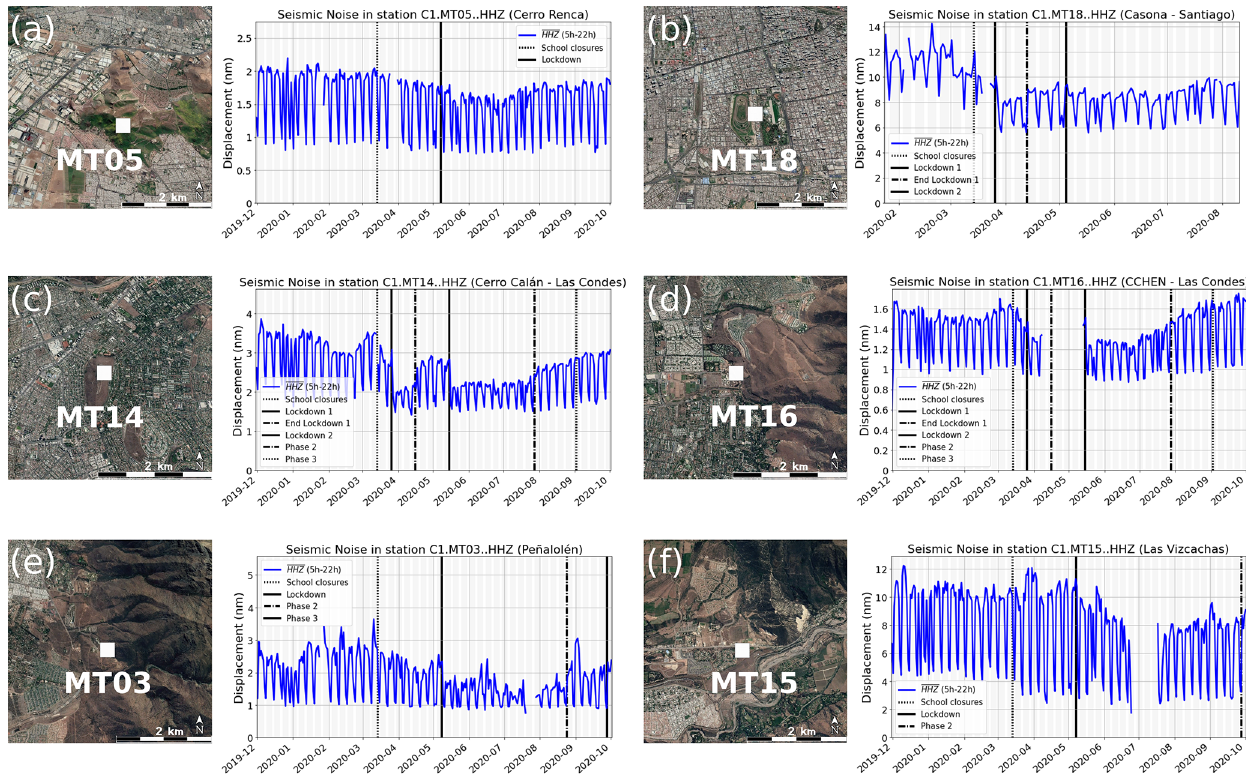
Figure 6. Changes in high-frequency seismic ambient noise amplitudes at stations (a) MT05, (b) MT18, (c) MT14, (d) MT16, (e) MT03, and (f) MT15. The vertical black lines indicate the time of public restrictions implemented in the metropolitan region. Each municipality inside the region had different lockdown periods or phases, despite the proximity between them. Photos from © Google Earth.